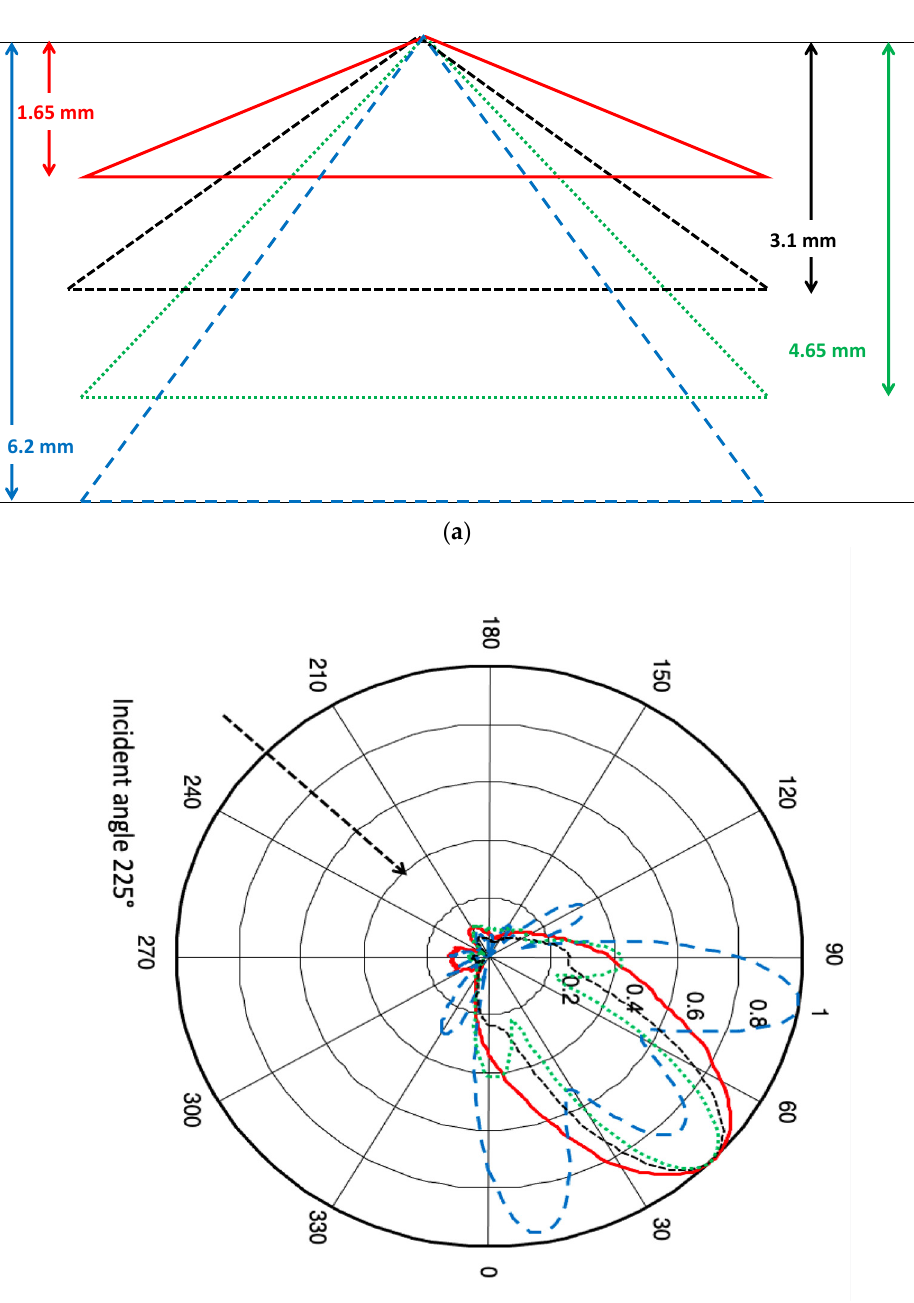
Figure 13. Effect of the conical depths: ( a ) Schematics of four different through-thickness depths (1.65 mm: red, 3.1 mm: black, 4.65 mm: green and 6.2 mm: blue), ( b ) normalized scattered amplitudes A 0 mode for different depths.